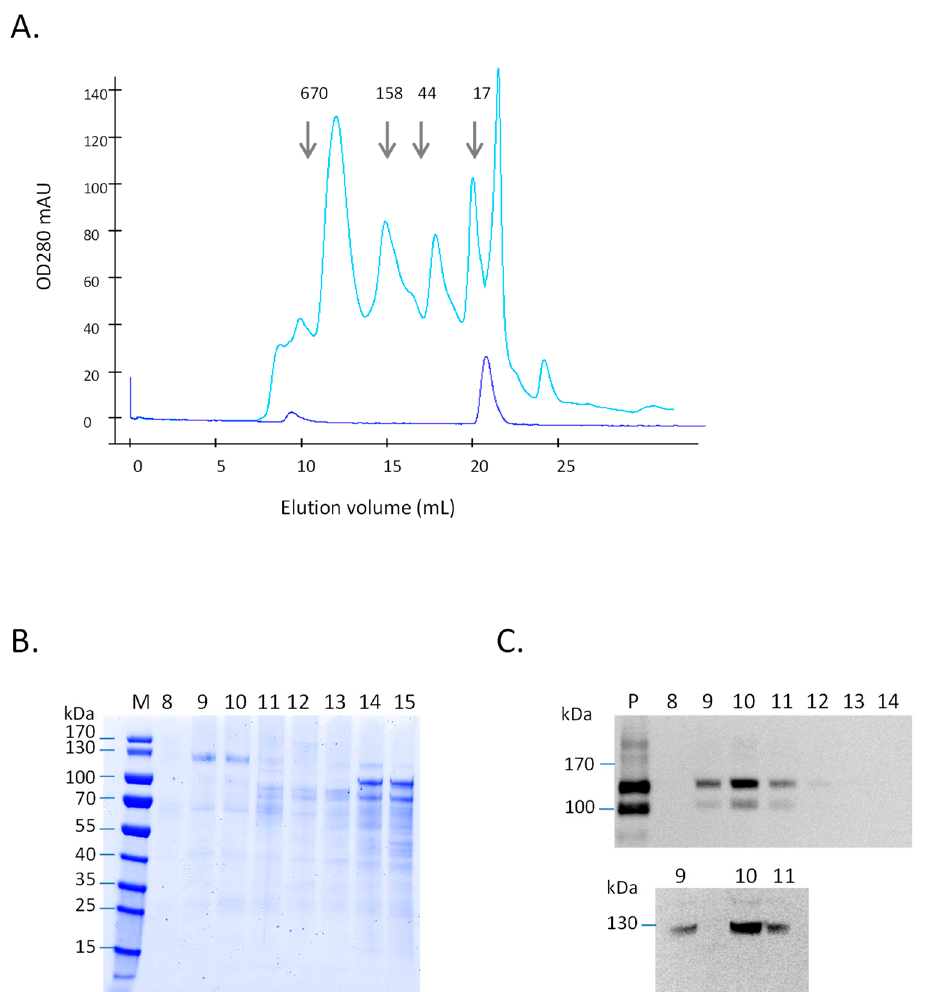
Figure 2. Purification of gB ectodomain produced in BY-2 extracellular medium by SEC. ( A ) Overlay of size exclusion chromatograms of line gB5 extracellular medium (corresponding to 20 mL precipitated with (NH 4 ) 2 SO 4 —light blue) and purified CHO-produced gB ectodomain (7 µ g—dark blue). The elution volumes of the 670 kDa, 158 kDa, 44 kDa and 17 kDa standards are marked with arrows. ( B ) Coomassie-blue stained SDS-PAGE of fractions eluted from SEC (Size-Exclusion Chromatography). M: Precision Protein Color Standards. Fractions 8–15 eluted from size exclusion chromatography (40 µ L) of extracellular medium line gB5. ( C ) Western blot analysis of fractions eluted from SEC. Top, P: line gB5 extracellular medium precipitated pellet (10 µ L—corresponding to 0.7 mL of extracellular medium); Fractions 8–12 collected after SEC of extracellular medium from gB line 5 (40 µ L). Bottom, Fractions 9–11 collected after SEC of CHO-produced gB (40 µ L). Western blotting using anti-gB antibodies was performed as indicated in Materials and Methods.